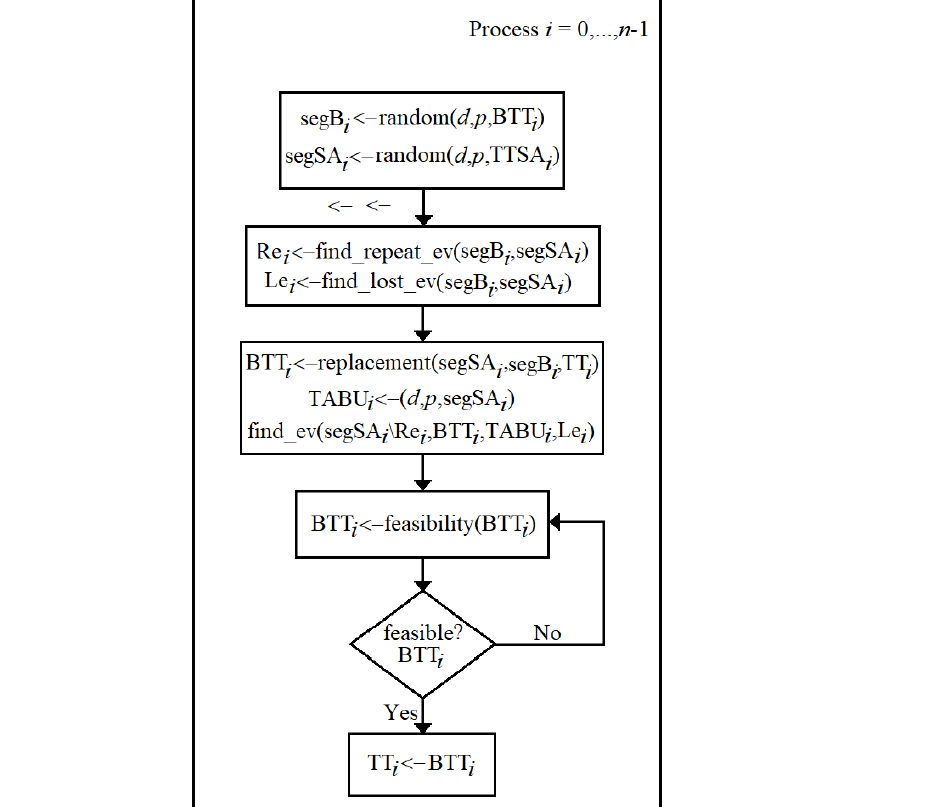
Figure 2. Simulated annealing with cooperative processes (SACP).